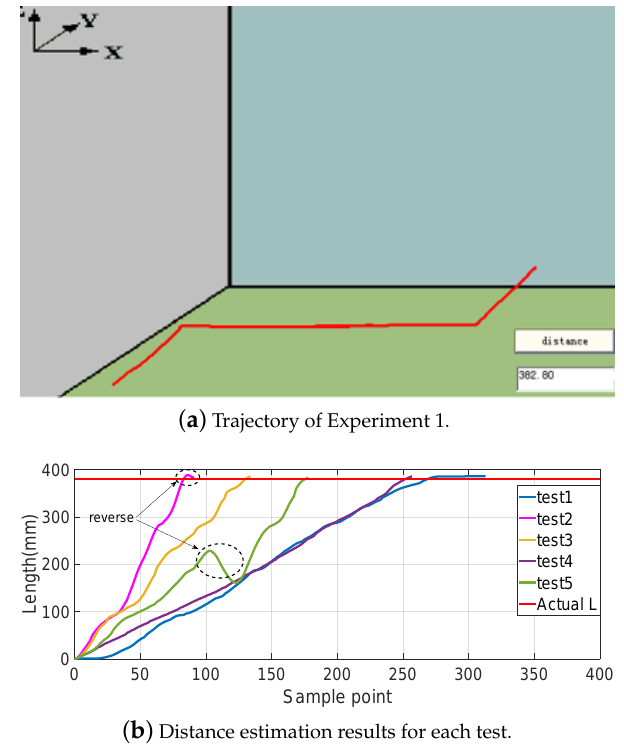
Figure 8. Experiment 1: a Z-shape track with a length of 380 mm.